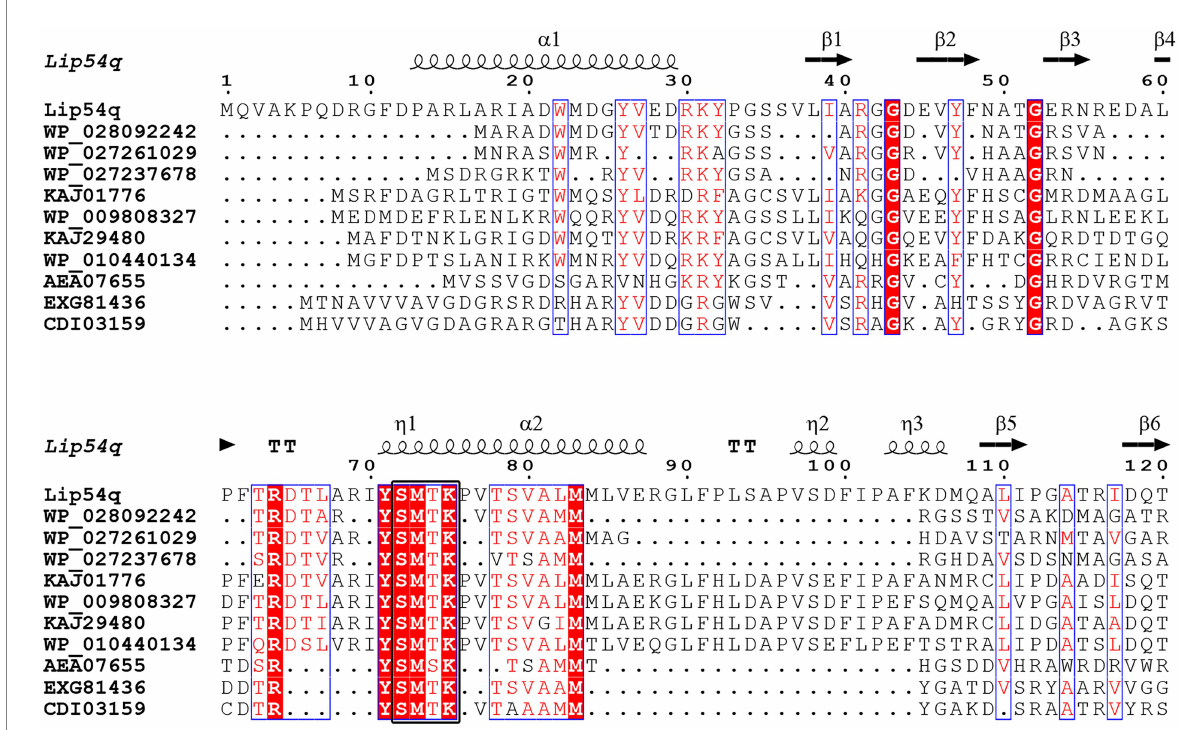
FIGURE 1 Multiple amino acid sequence alignment of Lip54q with several of its closest homologs. Several homologous amino acid sequences were obtained from NCBI GenBank. Sequence alignment was performed using Clustalx 2.1 and visualized using ESPript 3.0. The alpha helix, beta sheet, random coil and beta turn are indicated by α , β , η and T, respectively. The conserved sequences are indicated by blue boxes, and similar sequences are indicated by red backgrounds. The characteristic conserved S-M-T-K sequence of the Family VIII of lipolytic enzymes is indicated by a black